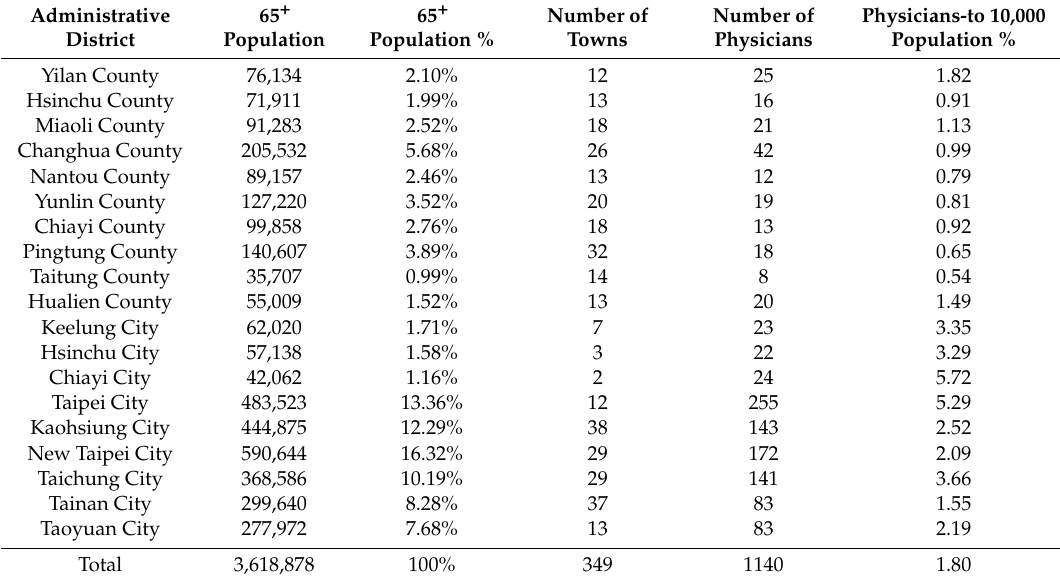
Table 2. Summary statistics of 65 + population and physical rehabilitation physicians’ scores by administrative districts (method